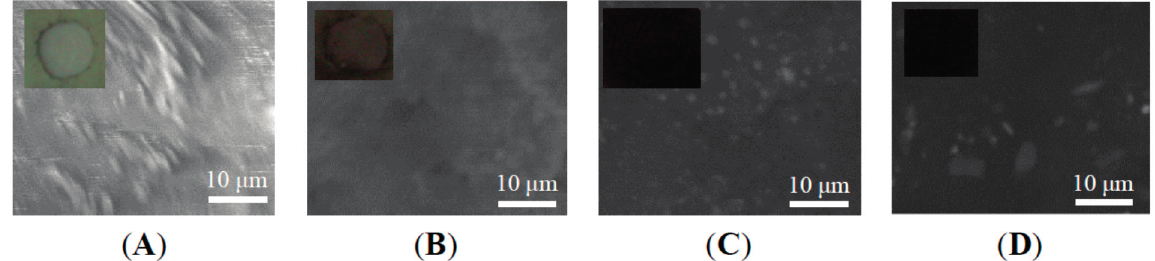
Figure 2. SEM of GNS-based epoxy resin coating with various content of ( A ) 0; ( B ) 0.1 wt %; ( C ) 0.4 wt %; and ( D ) 0.7 wt %. The corresponding digital photographs of GNS-based epoxy resin coating are shown in the